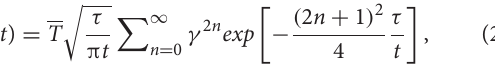
Figure 8 indicates the emergence distributions of crystals with angle θ between the DAC compression axis and < 0001 > of hcp iron, which means the frequency of hcp iron grains with angles between the c axis and compressional axis. This was calculated from < 0001 > pole figure (hence from ODF), and a distribution is normalized such that its integration in the hole interval to be